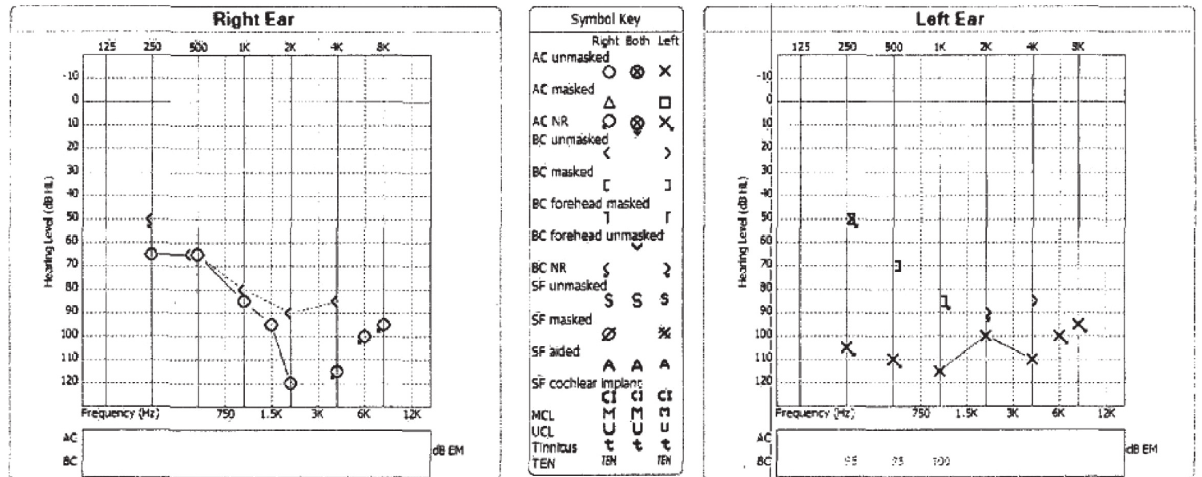
Figure 2: Audiogram at presentation showing profound bilateral hearing